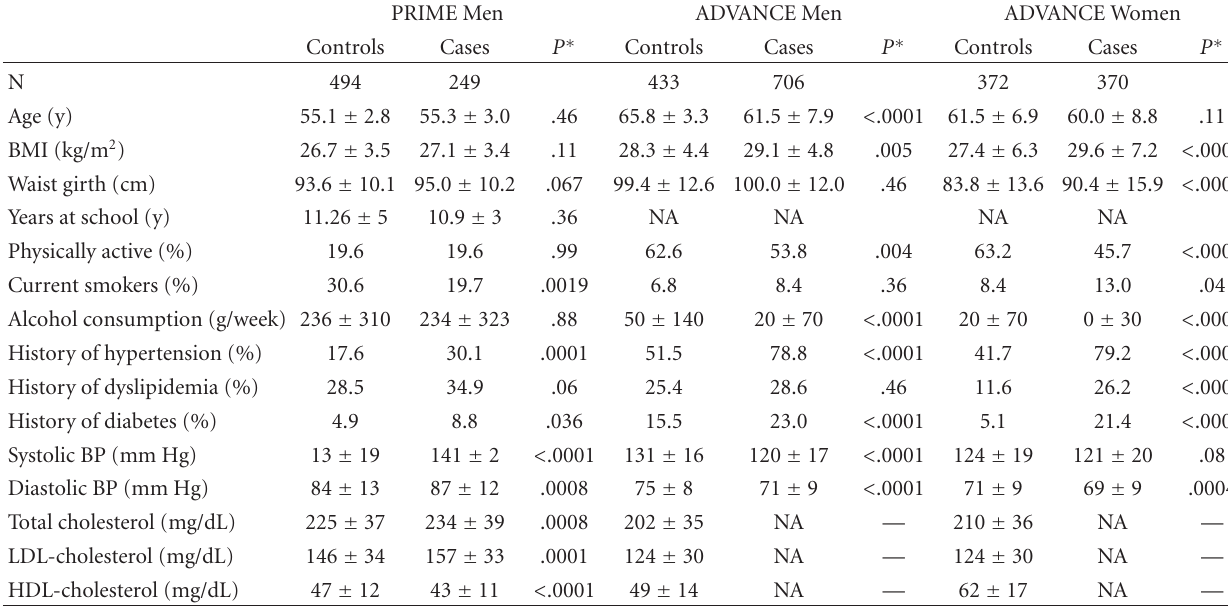
Table 1: Baseline characteristics of subjects with incident CHD (case) and CHD-free (control) subjects in PRIME and ADVANCE. PRIME Men ADVANCE Men ADVANCE Women Controls Cases P ∗ Controls Cases P ∗ Controls